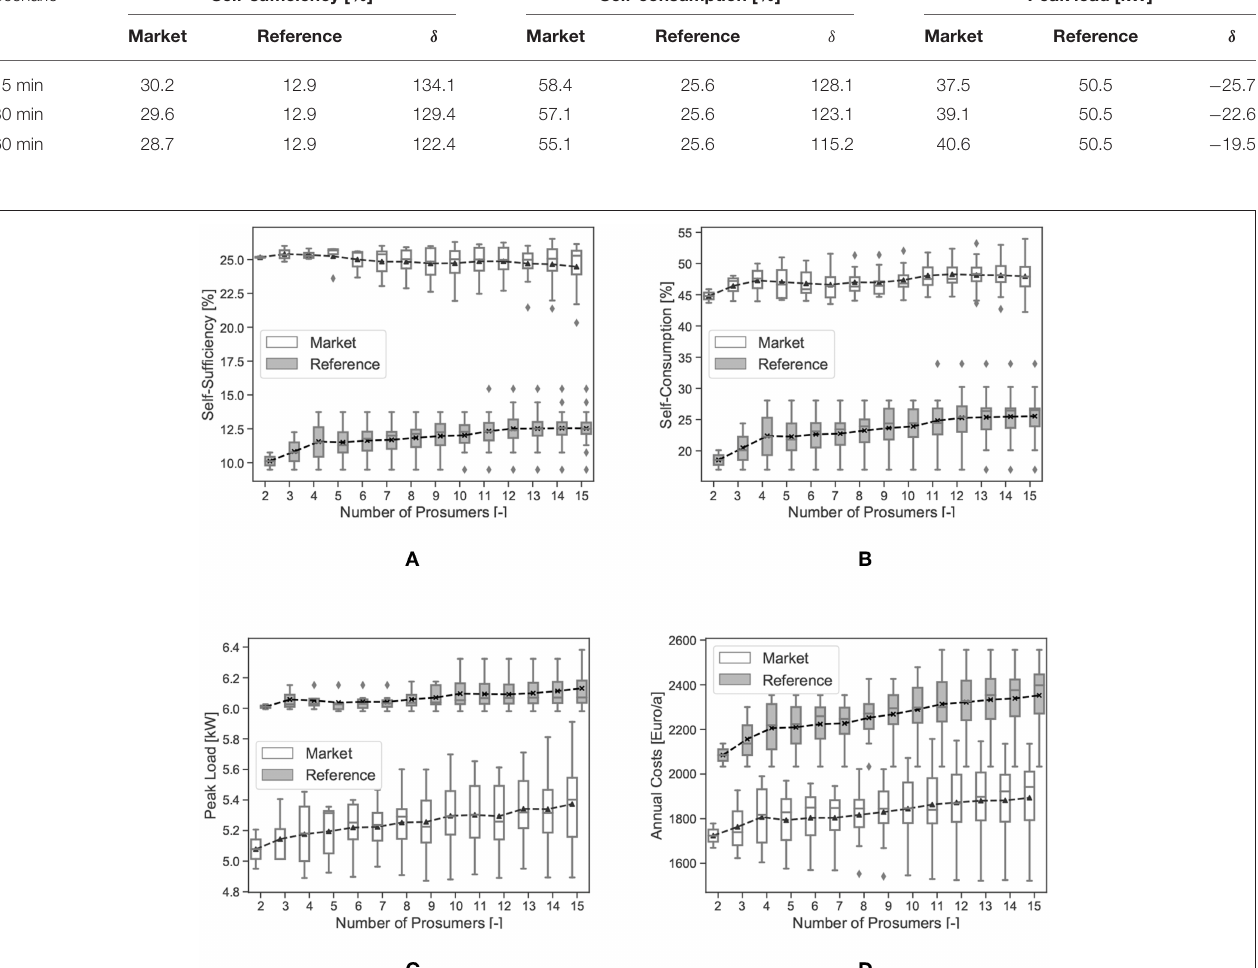
TABLE 2 | Comparison between different trading intervals at the microgrid level. Scenario